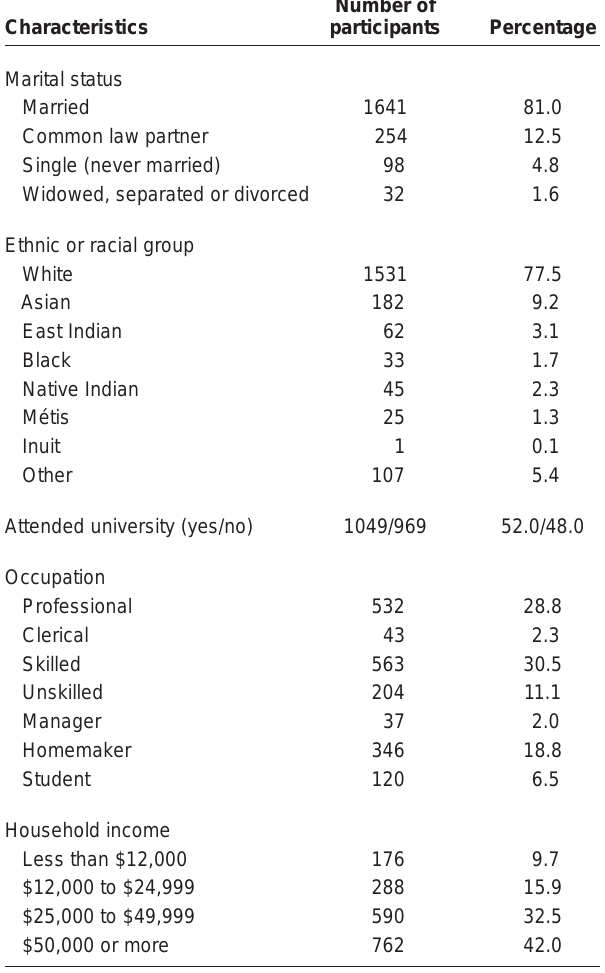
TABLE 2 Medical history of participants in the Edmonton Perinatal Study